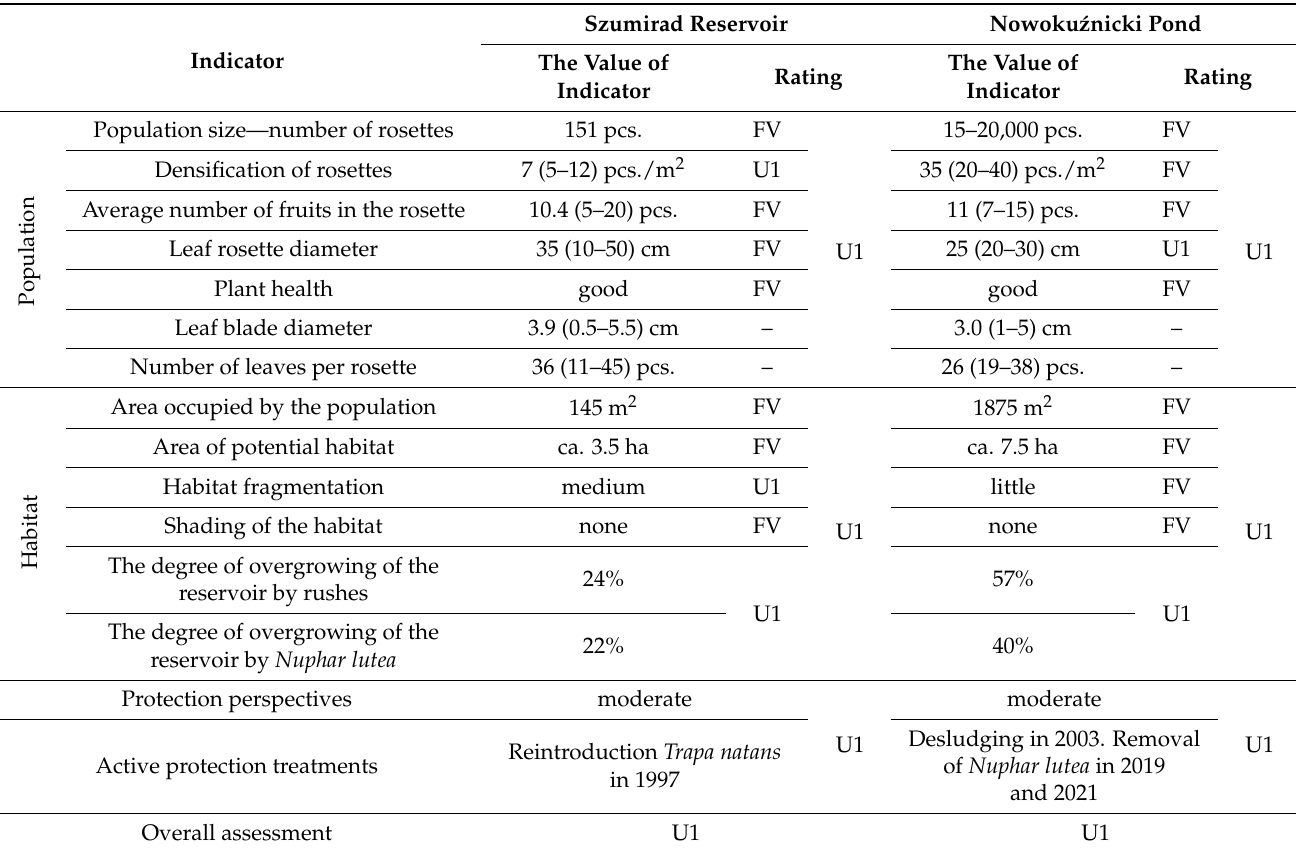
Table 2. The conservation status of the Trapa natans population in the analyzed ponds in 2014.